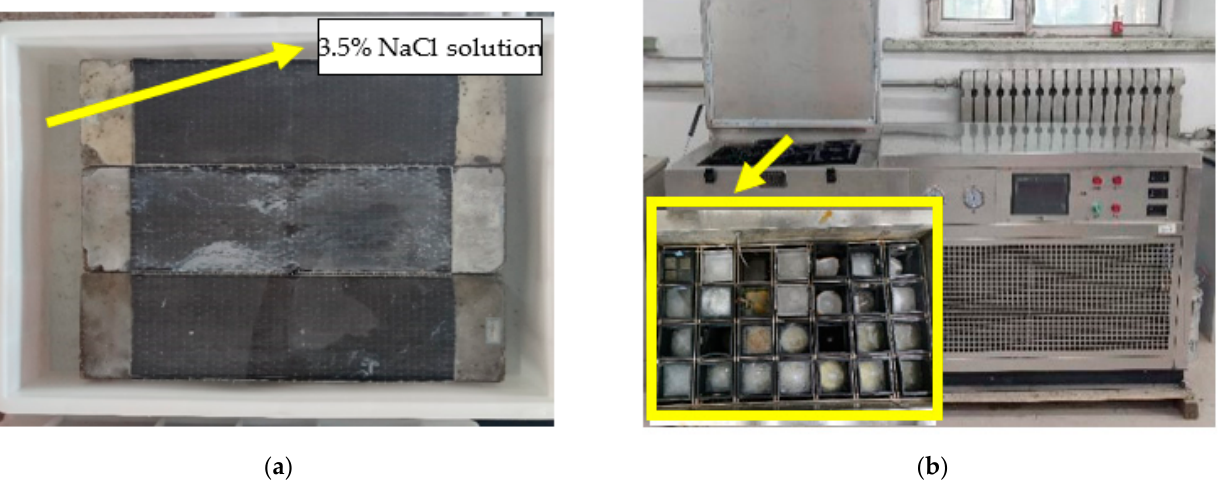
Figure 7. Exposure environment: ( a ) chlorine salt immersion environment and ( b ) salt-freeze coupled environment.